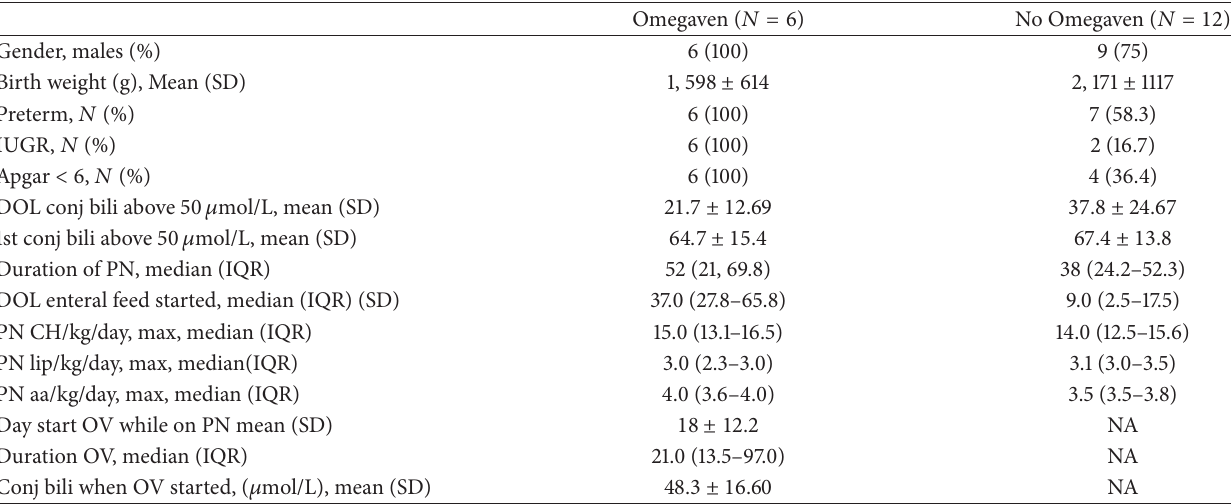
Table 3: Patient characteristics within cholestasis group.